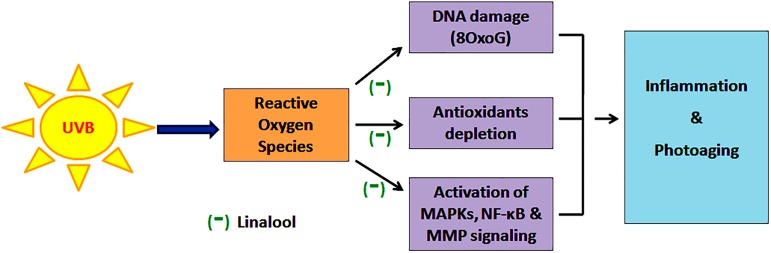
Linalool prevents (-) UVB-induced ROS mediated DNA damage, antioxidant depletion and subsequently MAPKs and NF-κB signalling and thereby prevents oxidative stress, inflammation and photoaging in HDFa cells.